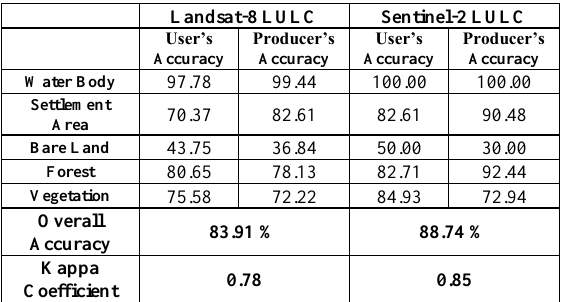
Table 2. Accuracy assessment results for LULC